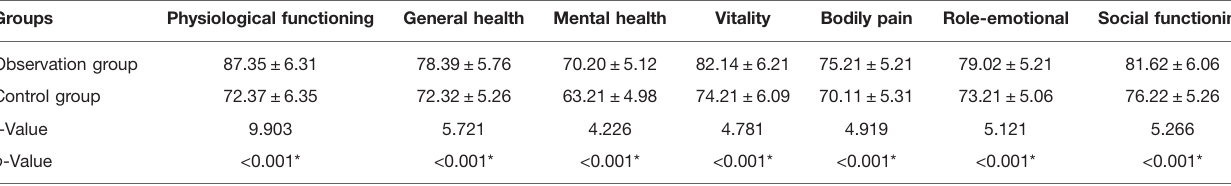
TABLE 4 | Comparison of quality of life after nursing care between two groups ( n =360, (cid:1) x + s ). Groups